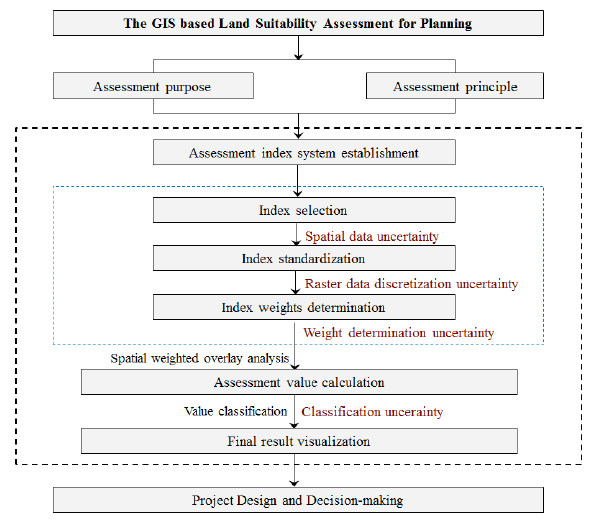
Figure 1. The flow chart of the land suitability assessment procedure in